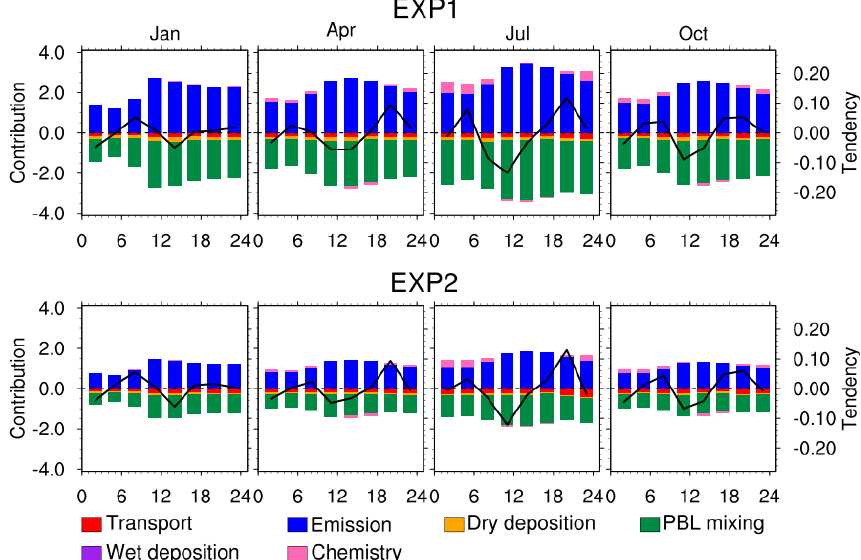
Figure 8. Relative contribution (normalized by monthly mean surface PM 2 . 5 concentrations for each month) to surface PM 2 . 5 concentra- tions every 3h from individual process (transport, emission, dry and wet deposition, PBL mixing, chemical production/loss) averaged over Hefei for January, April, July, and October of 2018 from experiments EXP1 and EXP2. The 3-hourly relative tendency of surface PM 2 . 5 concentrations is also shown as the black